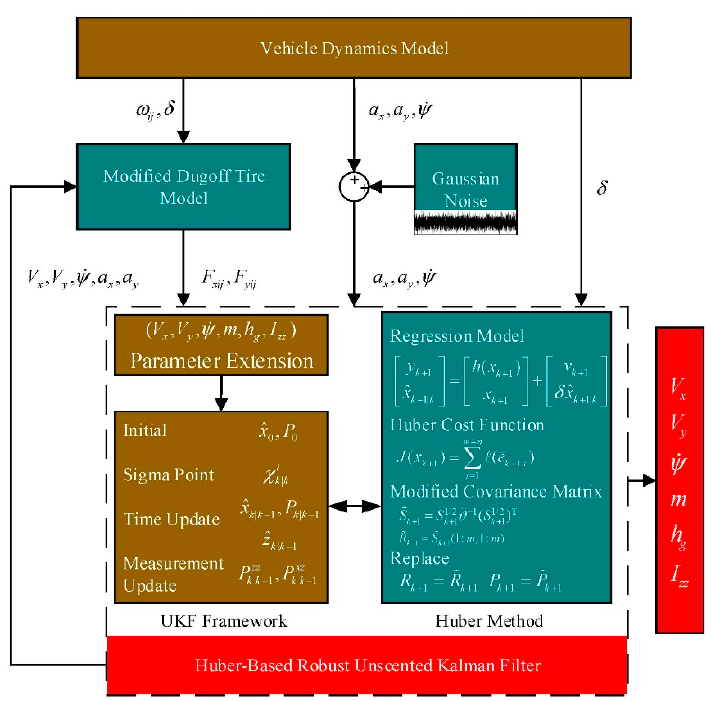
Figure 2. Diagram of Huber-based robust unscented Kalman filter (HRUKF) process.